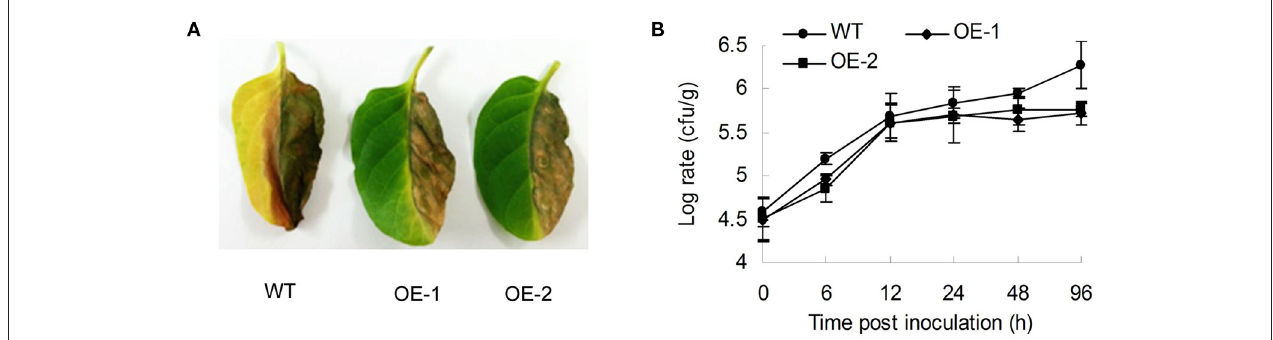
FIGURE 1 | Characterization of resistance to R. solanacearum for AtMYB12-expressing transgenic tobacco. (A) Performance of the wild type (WT) and two lines of AtMYB12 overexpression tobacco (OE-1, OE-2) after inoculation with R. solanacearum (OD600 = 0.5) for 3 days. (B) Growth curve of the R. solanacearum SD1 after the inoculation of 10 5 cfu in tobacco leaves. Bacterial numbers were counted 0, 6, 12, 24, 48, and 96h after infiltration. The values are the means ± SD ( n = 5).